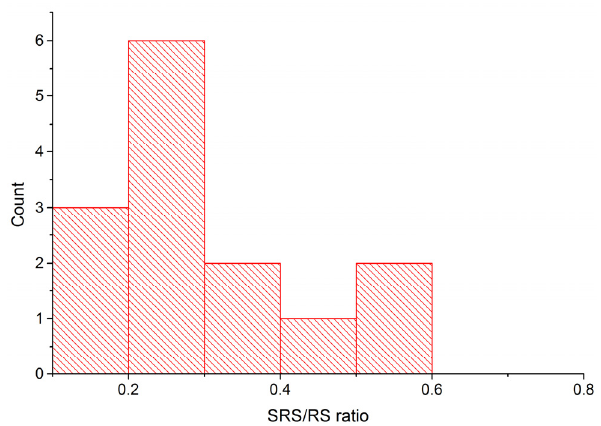
Figure 6. Distribution of subsequent return stroke to first return stroke (SRS/RS) ratio.